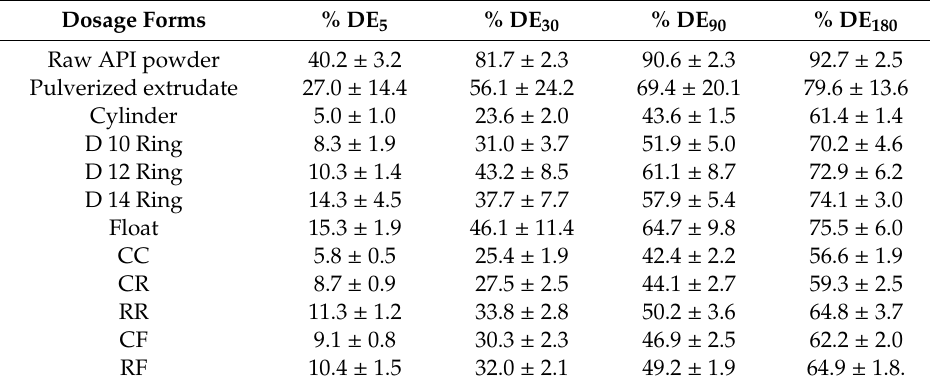
Figure 10. Dissolution rate of solid dosage forms in pH 6.8 phosphate bu ff er. Table 2. The % DE of dosage forms in pH 6.8 at 5, 30, 90, and 180 min. ( n = 6, Mean ±